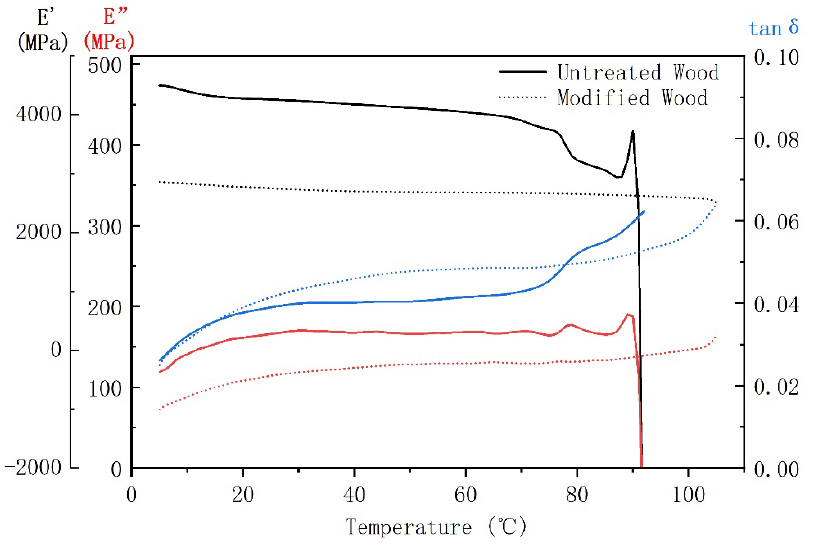
Figure 10. E (cid:48) (black line), E (cid:48)(cid:48) (red line) and tan δ (blue line) curves of untreated and furfurylated Figure 10. E ′ (black line), E ″ (red line) and tanδ (blue line) curves of untreated and furfurylated wood.